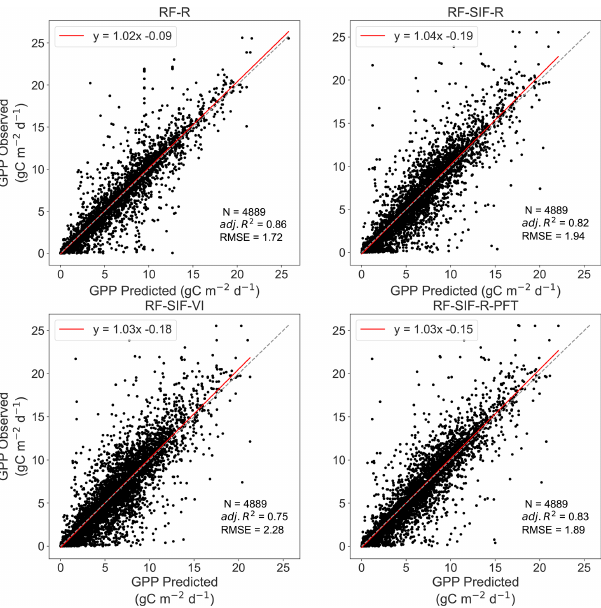
Figure 5. Scatterplots of the observed GPP against the RF-predicted GPP across all sites. N denotes the number of data points used for the RF model’s testing, adj. R 2 represents the adjusted coefficient of determination of the relationship between observed GPP and pre- dicted GPP, and the RMSE is the root mean square error between the observed GPP and RF-model-predicted GPP. The dashed diagonal line depicts the 1:1 line. RF- R denotes GPP prediction using only surface spectral reflectance; RF-SIF- R includes R and SIF d as in- puts to predict GPP; RF-SIF-VI integrates SIF d and VIs to estimate GPP; and RF-SIF- R -PFT includes R , SIF d , and plant functional type as categorical variables to predict